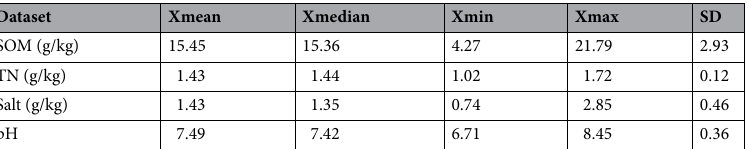
Table 3. Various meteorological variables and their descriptive statistics. In this table, the Xmean, Xmedian, Xmax, Xmin and SD represent the mean, median, maximum and minimum of the weather variables, standard deviation, respectively.